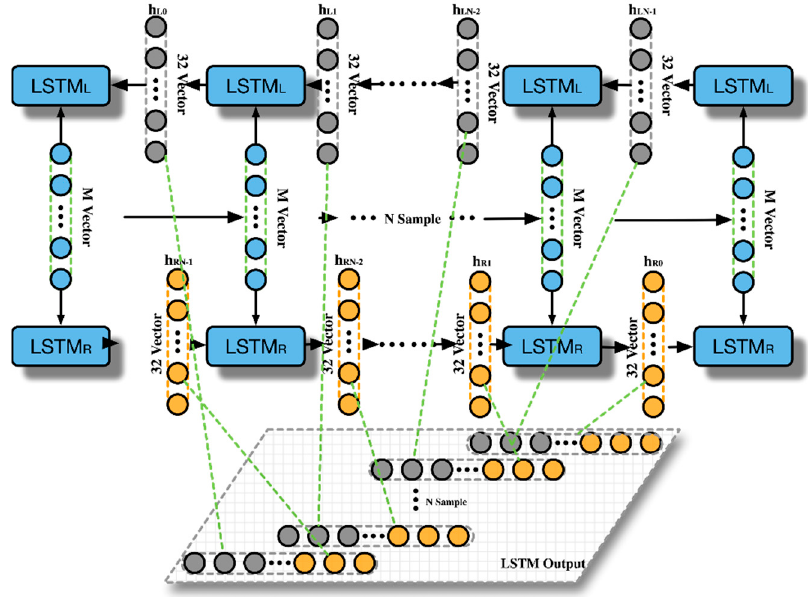
Figure 3. The bi-directional long short-term memory (Bi-LSTM) structure in the signal parameterized estimation network.